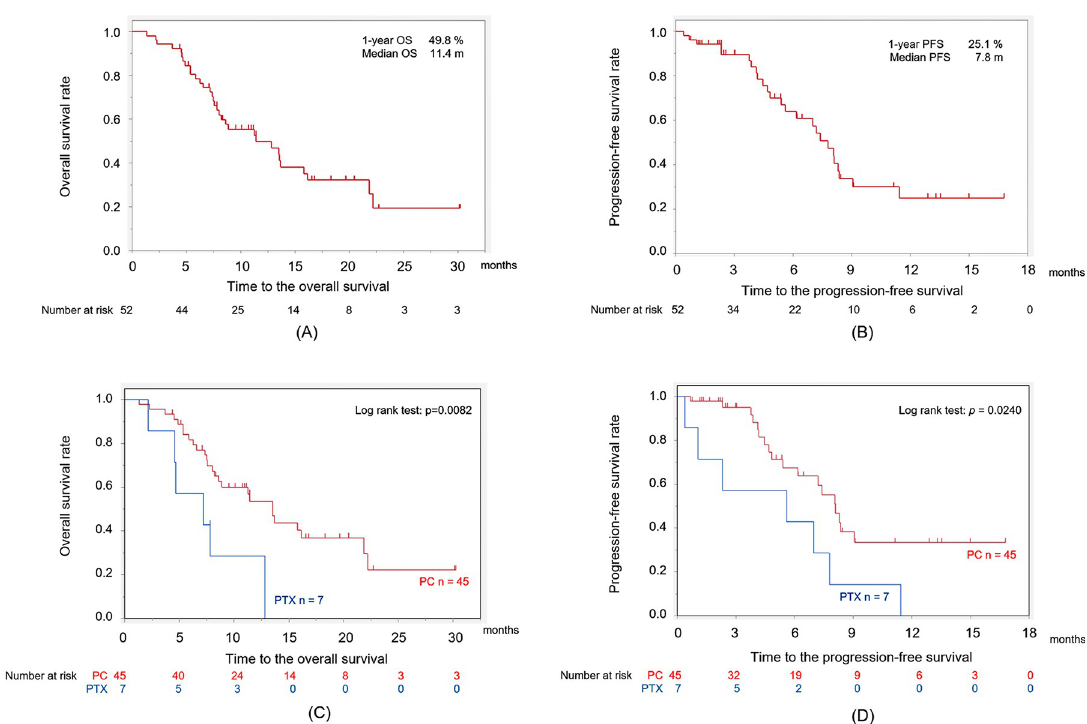
Fig 1. Kaplan–Meier curves for (A) overall survival and (B) progression-free survival in all R/M HNSCC patients who received SCT following nivolumab treatment. There were significant differences in overall survival (C) and progression-free survival (D) between the patients administered PC and those administered PTX (p = 0.0082 and p = 0.0240, respectively). R/M HNSCC, recurrent or metastatic head and neck squamous cell carcinoma; PC, combined chemotherapy of weekly paclitaxel and cetuximab; PTX, paclitaxel; SCT, salvage